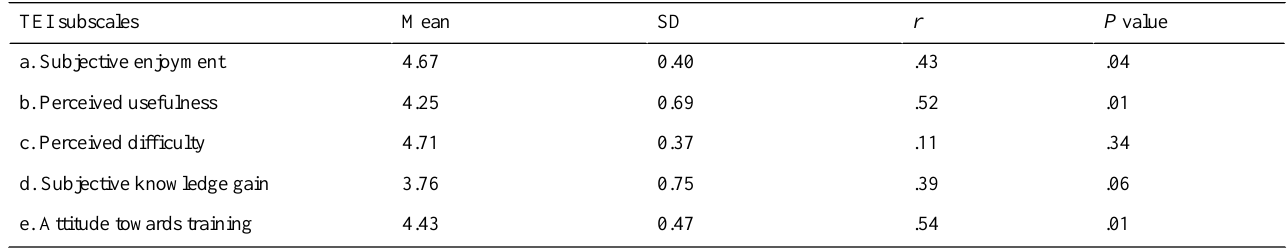
Table 2. Correlations between the Igroup Presence Questionnaire (IPQ; total score range, 0-6) and Training Evaluation Inventory (TEI) subscales (total score range,